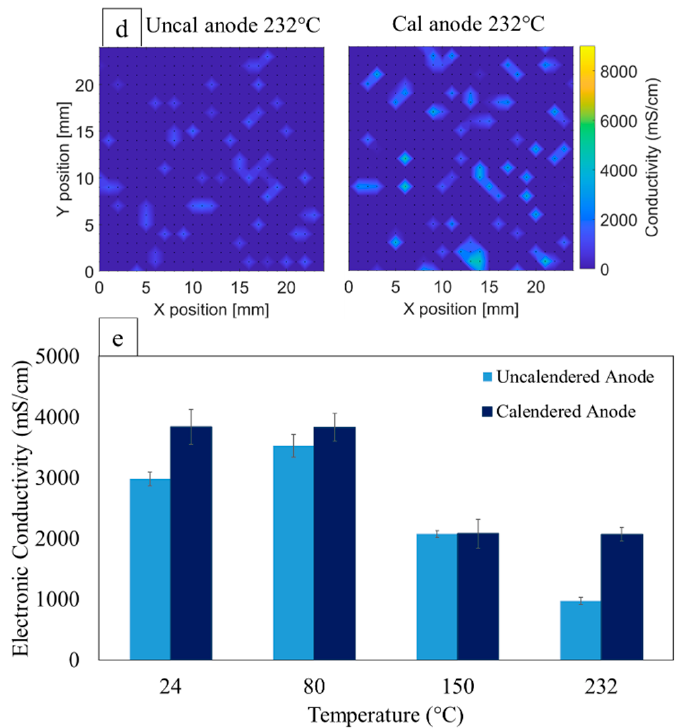
Figure 8. Electronic-conductivity maps of uncalendered and calendered anodes dried at ( a ) 24 °C, ( b ) 80 °C, ( c ) 150 °C, and ( d ) 232 °C, and ( e ) comparison between the average electronic conductivity ( b ) 80 ◦ C, ( c ) 150 ◦ C, and ( d ) 232 ◦ C, and ( e ) comparison between the average electronic conductivity of anodes before and after calendering. of anodes before and after